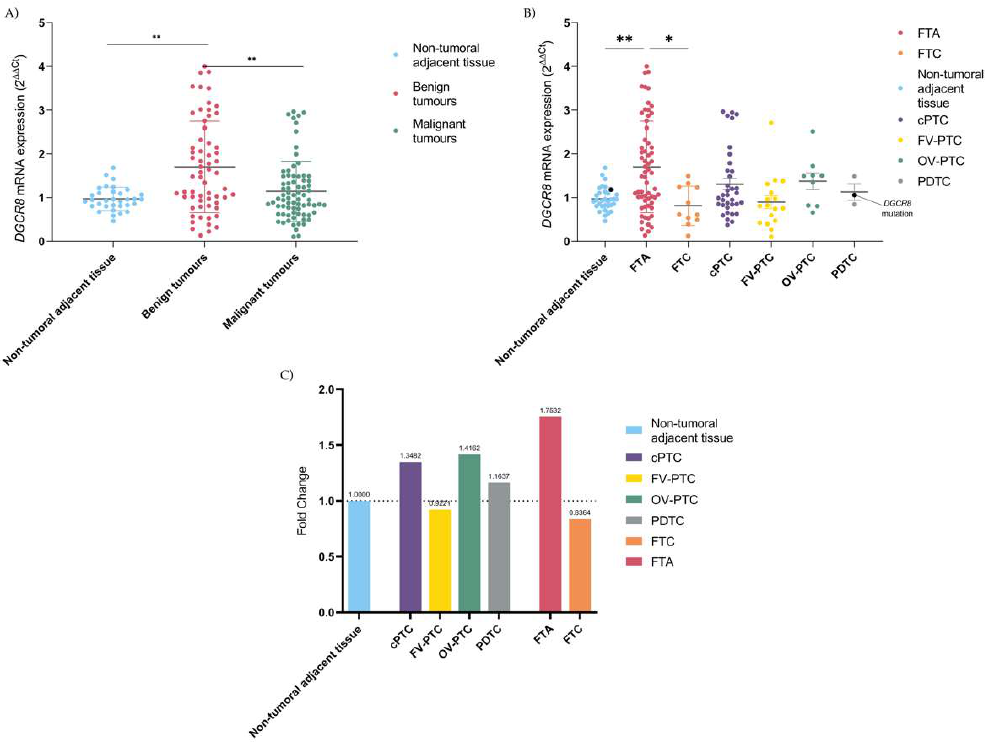
Figure 1. Expression of DGCR8 mRNA in thyroid: ( A ) Comparison between NTAT and benign tumours ( p = 0.005), and between benign and malignant tumours ( p = 0.004); ( B ) Comparison of the expression according to the histotype, with overexpression of FTA significantly different from FTC ( p = 0.01) and NTAT ( p = 0.004)–DGCR8 mutated case and the correspondent NTAT are in black; ( C ) Fold-change of DGCR8 mRNA expression using NTAT as a normalizer (=1) reveals that FV-PTC and FTC are the lesions that present the higher ratios for underexpression, in contrast with the other subtypes, being cPTC and FTA the lesions with a higher gain. * Kruskal–Wallis test statistical significance p < 0.05; ** Kruskal–Wallis test statistical significance p < 0.01.